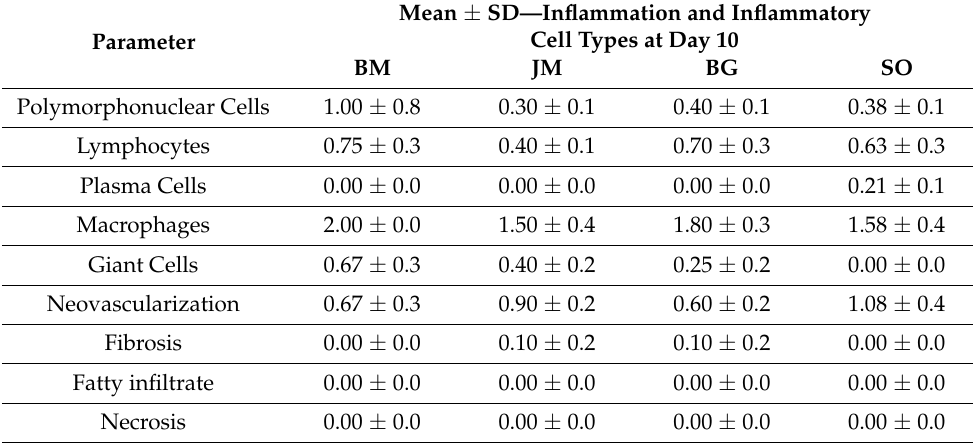
Table 4. Results of the biomaterial scoring evaluations at 10 days post implantationem. BM: bovine- based membrane, BG: Bio-Gide ® membrane, JM: Jason ® membrane, and SO: sham operation. Mean ± SD—Inflammation and Inflammatory Cell Types at Day 10 Parameter BM JM BG SO Polymorphonuclear Cells 1.00 ±